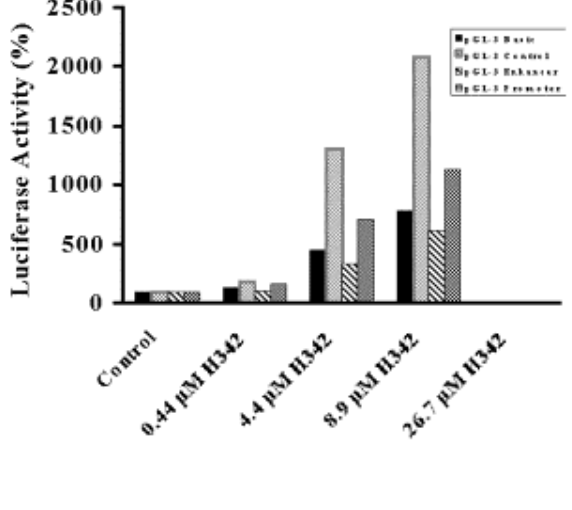
Fig 1. Effect of H342 on luciferase activity after transfection with 4 different luciferase expression vectors.